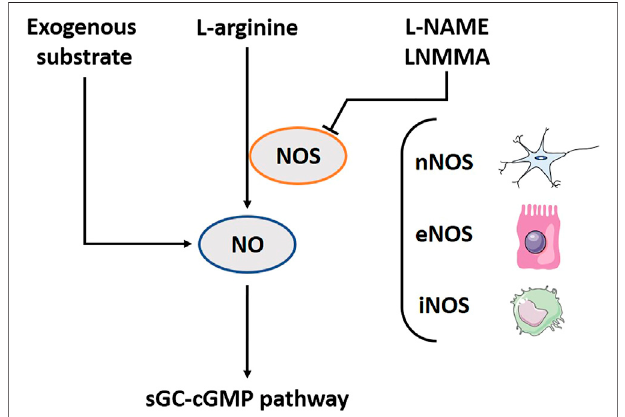
FIGURE 2 | The carbon monoxide (CO) pathway including involved substrates, enzymes and downstream pathways. CO is produced during the catabolism of haem by two oxygenase proteins, HO-1 and HO-2, but it can also be released in small amounts by intestinal bacteria. Interestingly, severalexogenoussubstratestoinducethepathwayexist.COprefersbinding hemoglobin, and this complex has a long half-life time up to 4 h. CO ’ s biological functions are related to the activation of sGC; subsequently in fl uencing cGMP, but other pathways such as the COX or inhibition of cytochromeP450havealsobeenexplored.HO-1,Haemoxygenase1;HO-2, Haemoxygenase2;COHb,CO-haemoglobincomplex;sGC,Solubleguanylyl cyclase; cGMP, Cyclic guanosine monophosphate; COX,